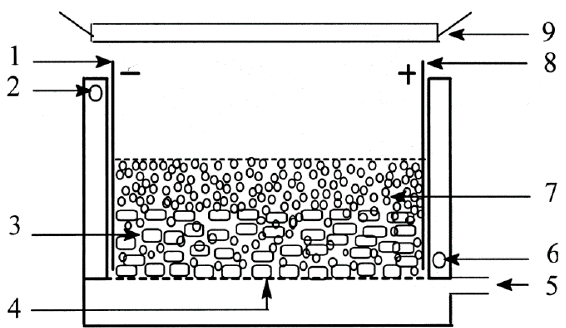
Figure 25. Schematic diagram of the three-dimensional electrode slurry photocatalytic reactor. (1) Cathode; (2) outlet of recycled water; (3) GAC layer; (4) micropore plate; (5) inlet of pressured air; (6) inlet of recycled water; (7) titanium dioxide layer; (8) anode; (9) UV irradiation. (Reproduced with